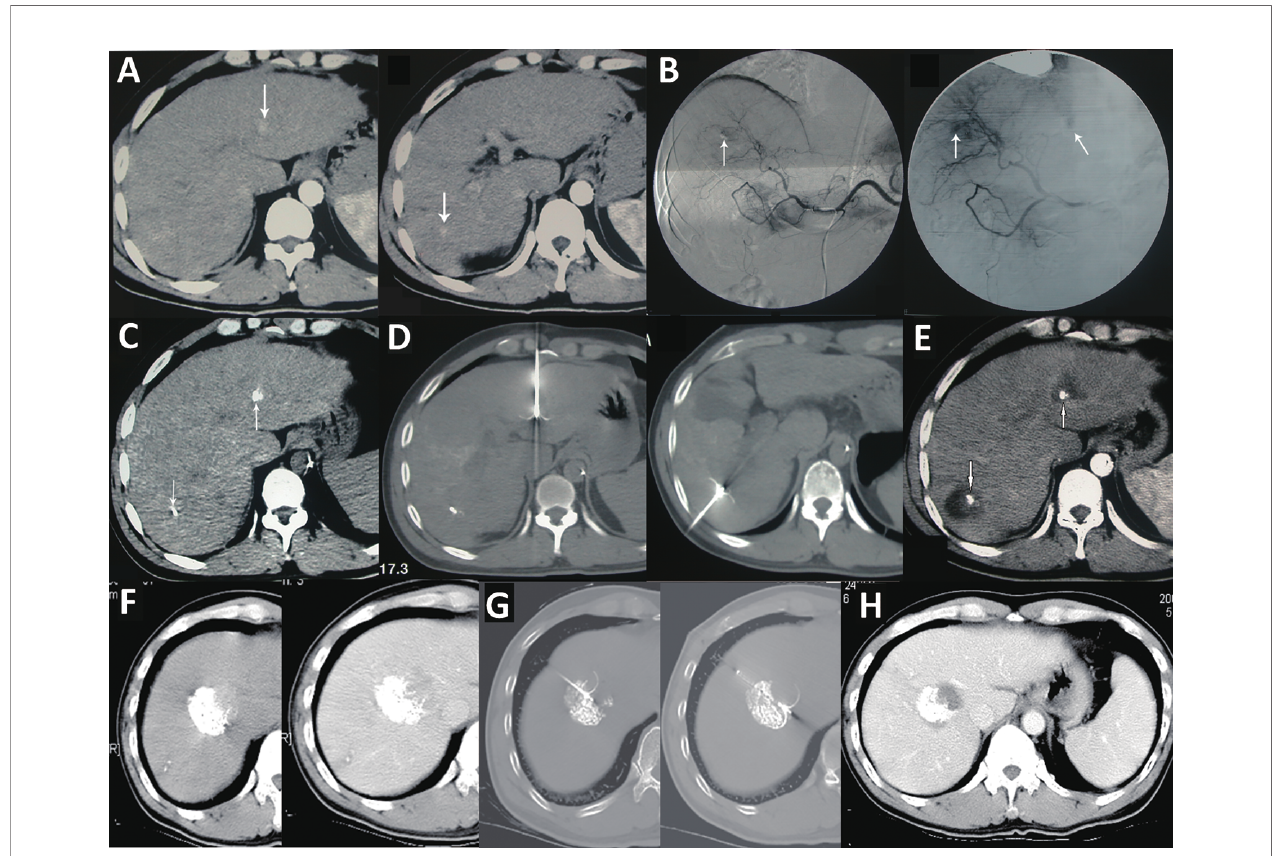
FIGURE 5 | TACE combined with ablation is the preferred treatment for HCC at an ideal location. (A) A case of HCC with a progressively increased AFP level. Liver CT shows two lesions in the left lateral segment and right posteroinferior segment of the liver; (B) DSA during the TACE treatment showed staining of tumors in the left and right lobe (arrow); (C) Lp-CT con fi rmed two lesions; (D) CT-guided radiofrequency ablation of lipiodol deposited lesions; (E) One month after combined treatment, AFP decreased to a normal level, and no tumor recurrence was observed fi ve year later in the follow-up CT scan. (F) Another case of HCC after TACE treatment combined with radiofrequency ablation treatment (G) ; (H) A 15-year postoperative follow-up examination showed complete inactivation of the